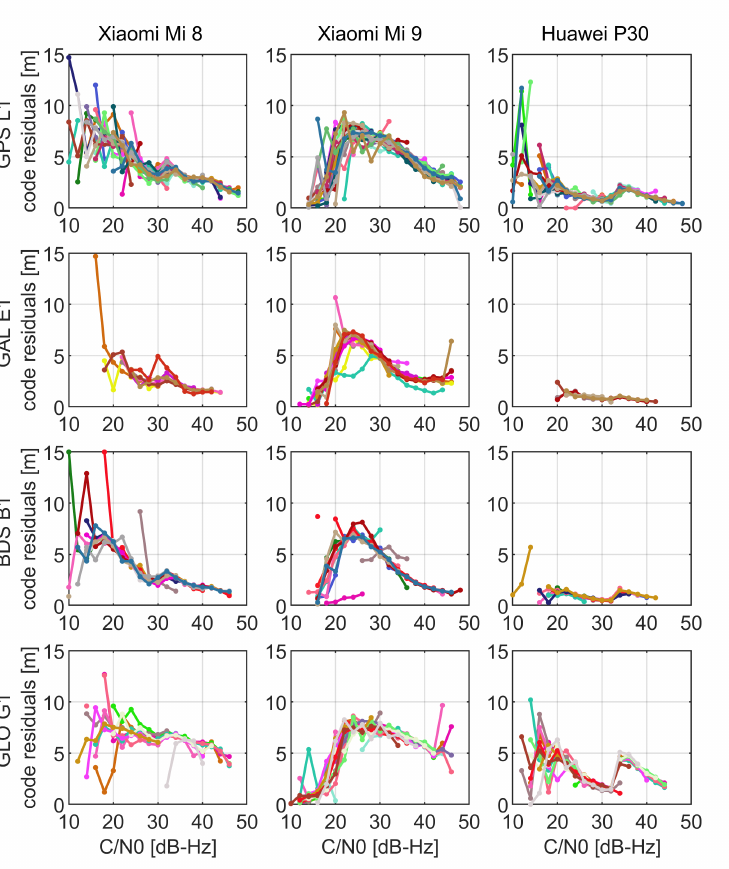
Figure 6. C / N 0 -dependent quality of code observations on GPS L1, Galileo E1, BDS B1, and GLONASS G1 frequency bands in 1st, 2nd, 3rd, and 4th rows, respectively. The results corre- sponding to different smartphones are distinguished by columns. Different colors represent different satellites. Code residuals were computed as the observations that were double differenced in a time domain. The values are averaged for particular satellites in 1 dB-Hz